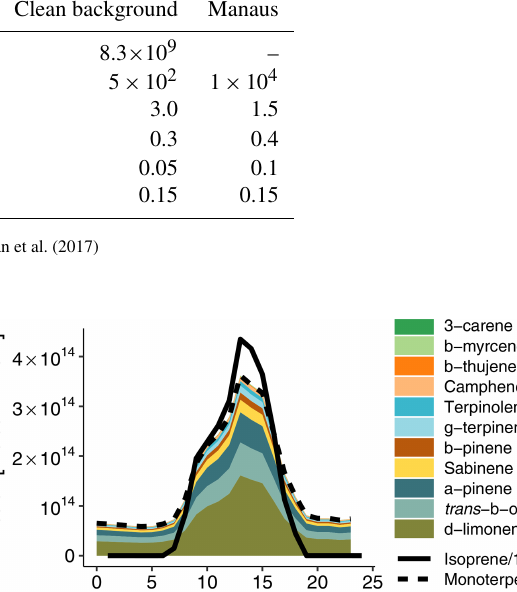
Clean background